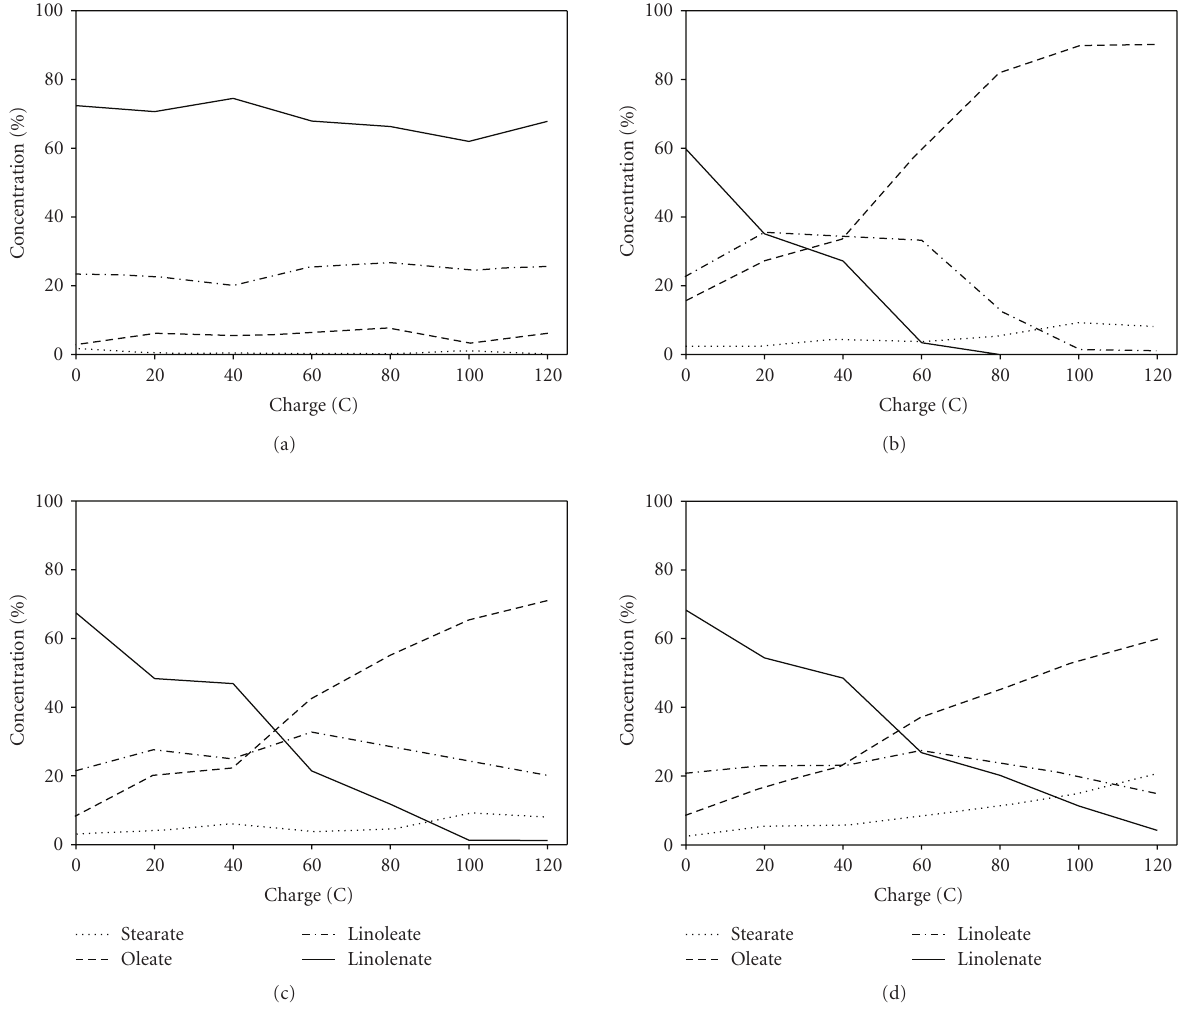
Figure 3: Distribution of products of the ECH of linolenic acid as a function of charge consumed on (a) Pd in ethanol/water 70: 30, pH 13 (b) Pd/Al 2 O 3 in ethanol/water 70:30, pH 13 (c) Pd in ethanol/water 70 :30, pH 5 (d) Pd/Al 2 O 3 in ethanol/water 70 :30, pH